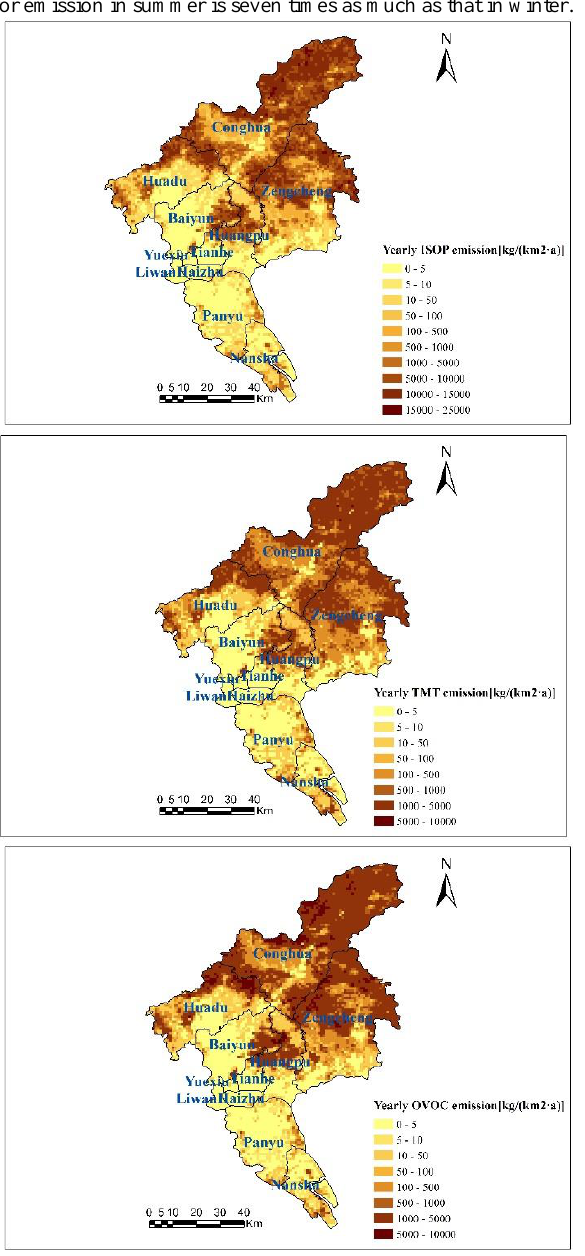
Figure 4. Spatial distribution of ISOP, TMT and OVOC in